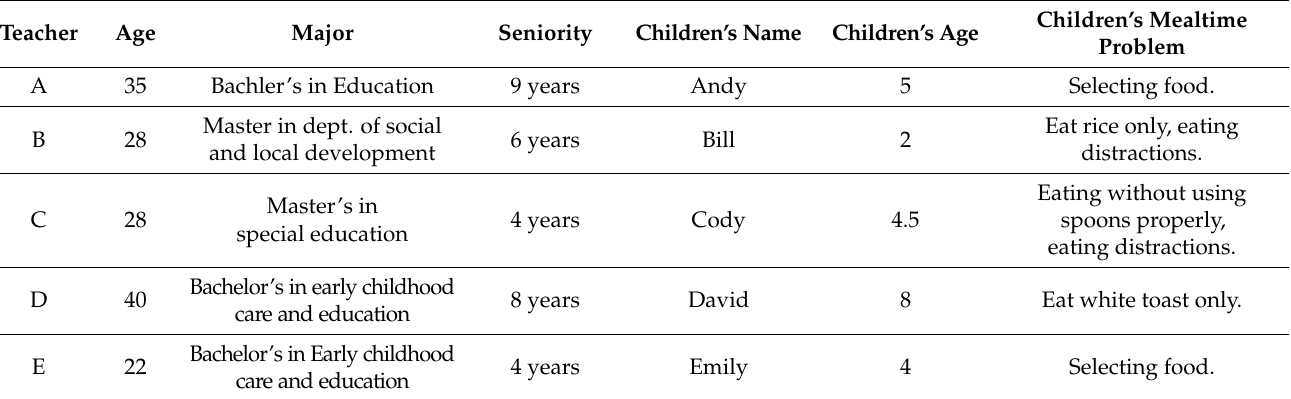
Table 1. The Background Information of the